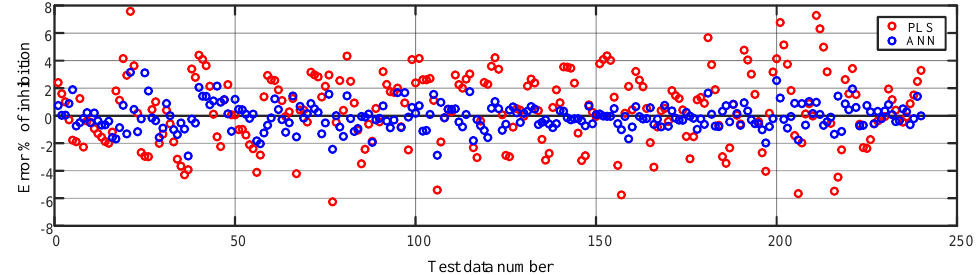
Figure 9. Percentage of inhibition model of QCT for Hep G2 cell with ZEAR. Surface of % of inhibition obtained using ( a ) ANN model and ( b ) linear regression. Cross-sections of ( c ) ANN-based model and ( d ) linear regression model at QCT = 7.5 μg/mL (red) and QCT = 15 μg/mL (blue), which comprise the test area.